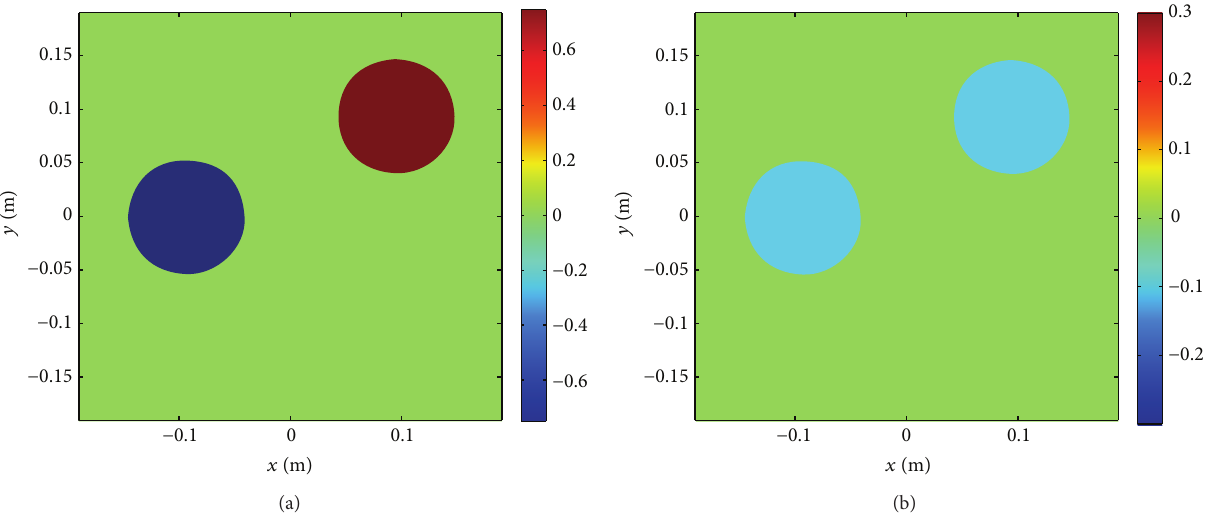
Figure 2: Example 1: reference profile. (a) Real and (b) imaginary parts of reference contrast function.